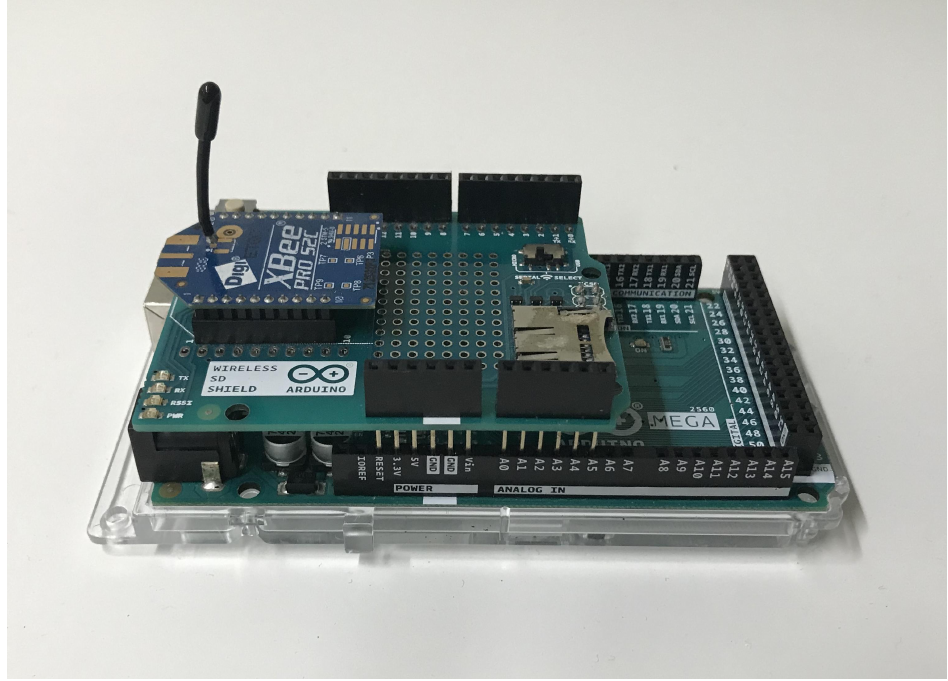
Figure 1. A picture of a CaBIUs